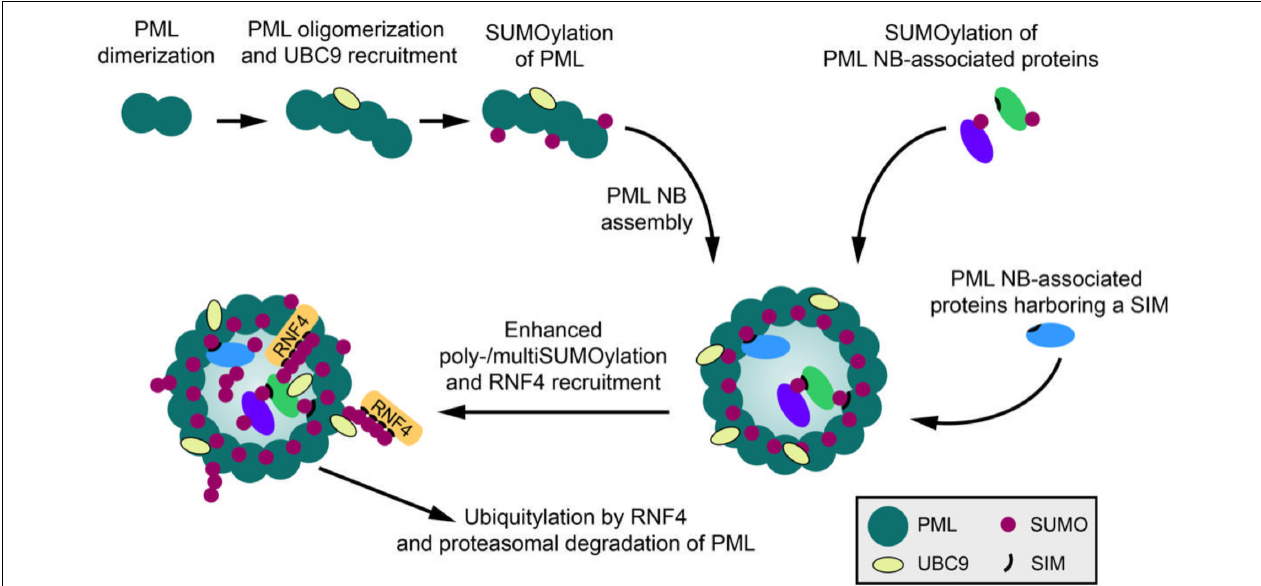
FIGURE 1 | SUMO and the dynamics of PML nuclear bodies. PML NB formation begins with PML oligomerization via its N-terminal domain. UBC9 is recruited to PML oligomers and PML is SUMOylated. PML SUMOylation and consequential SUMO-SIM interactions further promote PML NB assembly and the recruitment of PML NB-associated proteins into PML NBs. Stimuli such as arsenic trioxide treatment can lead to multi- and polySUMOylation of PML and NB-associated proteins. The StUbL RNF4 can subsequently ubiquitylate PML, thereby targeting it for proteolytic degradation and causing the clearance of PML